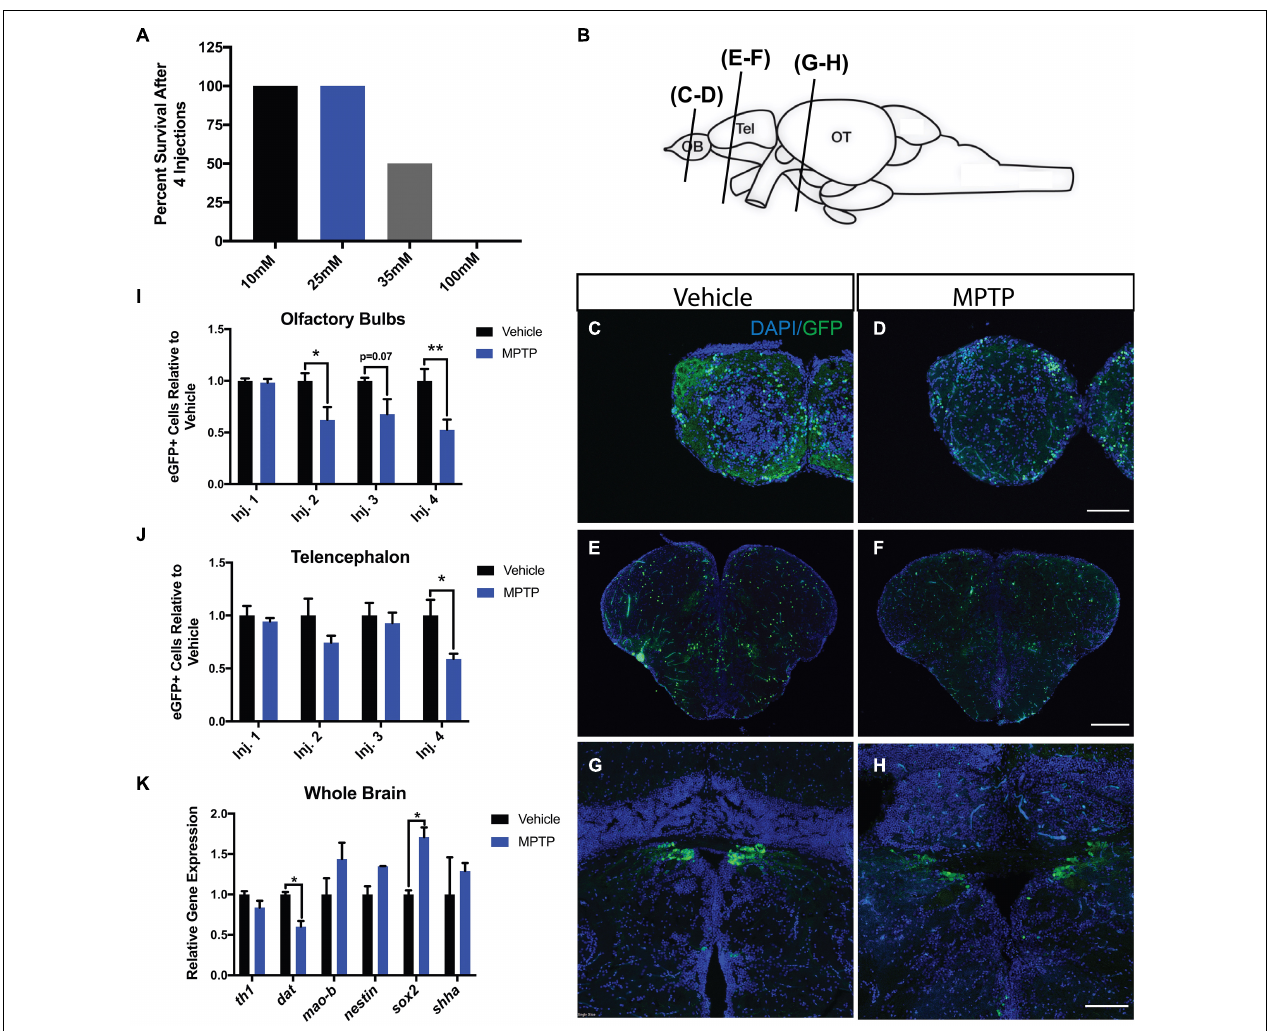
FIGURE 1 | Impact of MPTP on various brain regions of adult Tg( dat:eGFP ) zebrafish. (A) MPTP dose-response. (B) Schematic representation of the zebrafish brain with the planes of section indicated. Immunohistochemical labeling of eGFP (green) and DAPI (blue) to observe dopaminergic neurons in the olfactory bulbs (OBs) (C,D) , telencephalon (E,F) , and periventricular pretectal nucleus (PPv) (G,H) . (I,J) Quantification of eGFP+ cells within the OBs and telencephalon respectively. ( n = 6). (K) Whole brain qRT-PCR analysis for dopaminergic, and regeneration-related genes; th1 , dat , sox2 , nestin , and shha. ( n = 3 whole brains from each respective group). Bars represent the mean ± the SEM. * p < 0.05, ** p < 0.01. Scale bars = 100 and 200 µ m for the OB/PPv and telencephalon respectively. OB, olfactory bulbs; Tel, telencephalon; OT, optic